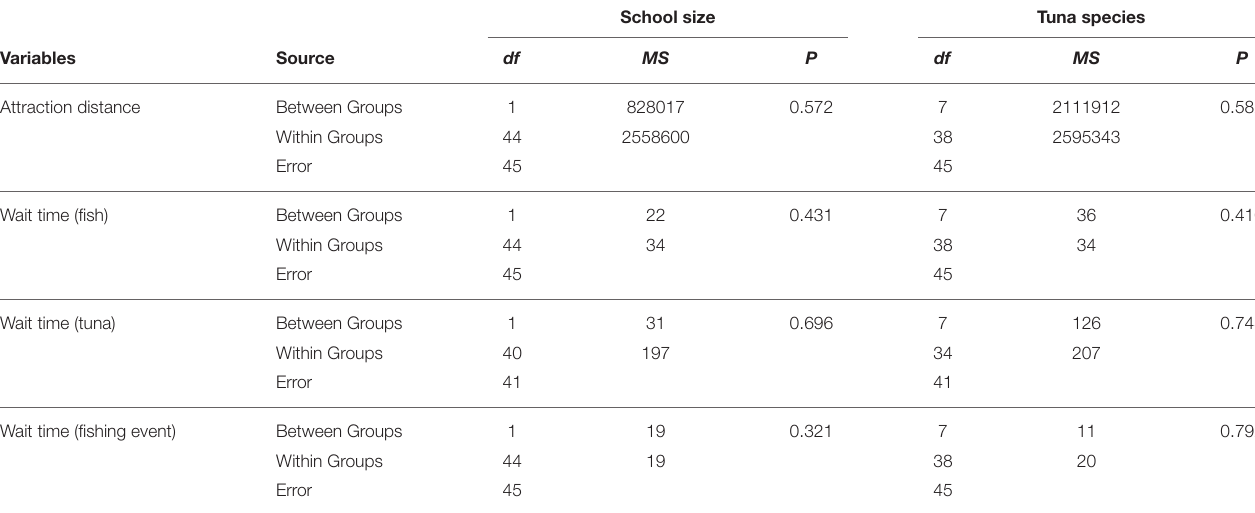
TABLE 3 | Variables tested for its association with the reported fish school size and various tuna species using one-way